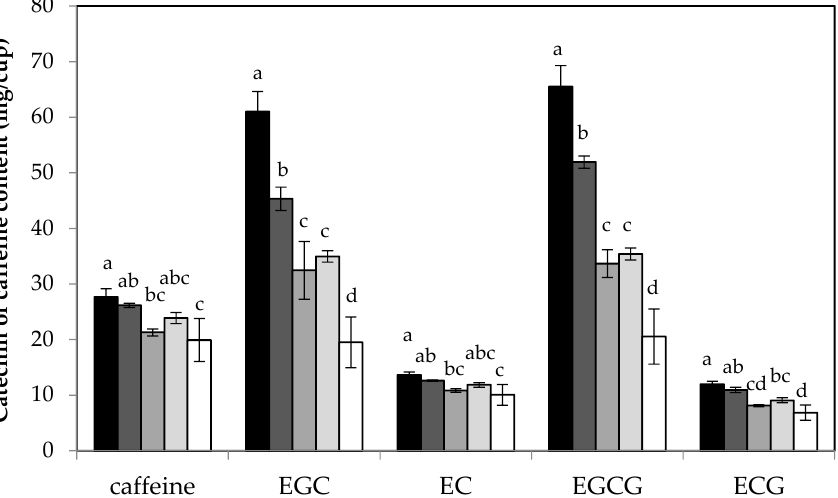
Figure 3. HPLC analysis of green tea (Lipton green tea purchased in Fall 2017) prepared with synthetic freshwater ranging from very soft (black columns) to very hard (white columns). The column height is the average of three tea preparations and the error bar is the standard deviation. Different letters (a–d) represent statistically different mean values for each compound compared across different water hardness